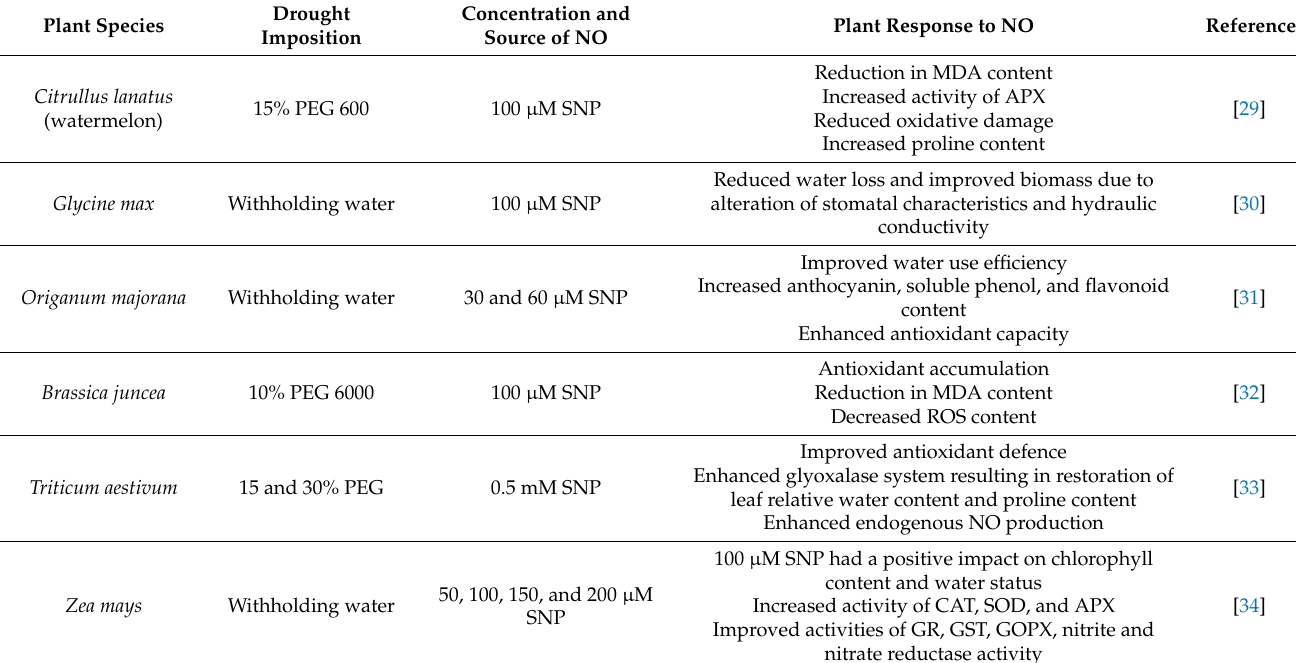
PEG: Polyethylene glycol; NO: Nitric oxide; SNP (Sodium nitroprusside); acts as NO donor; MDA: Malondialdehyde; APX: Ascorbate peroxidase; ROS: Reactive oxygen species; CAT: Catalase; SOD: Superoxide dismutase; GR: Glutathione reductase; GST: Glutathione S-transferase; GOPX: Guaiacol